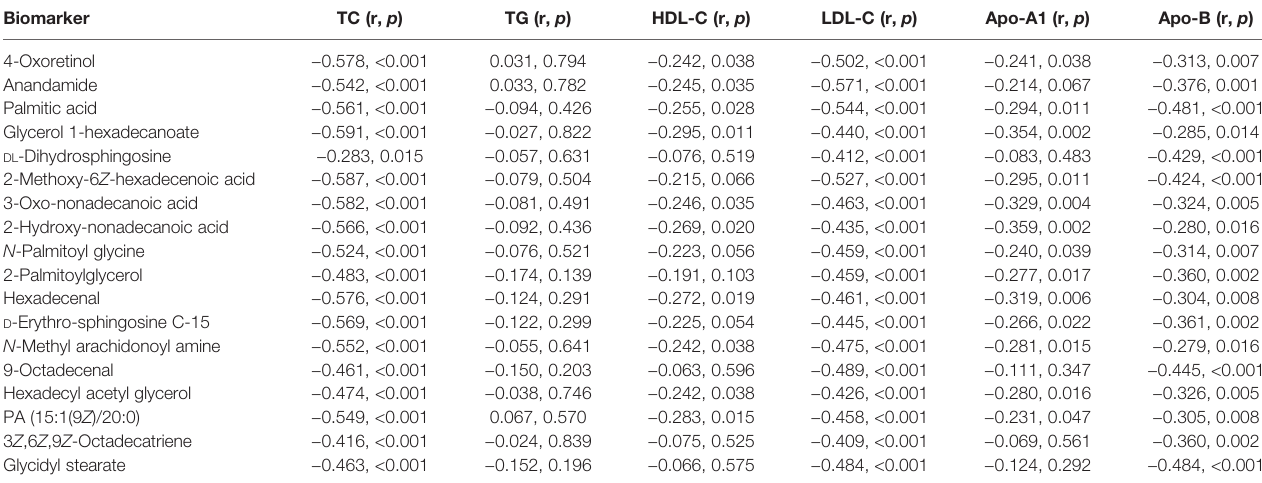
TABLE 5 | Correlation analysis of differential metabolites and commonly used fasting lipid pro fi les.